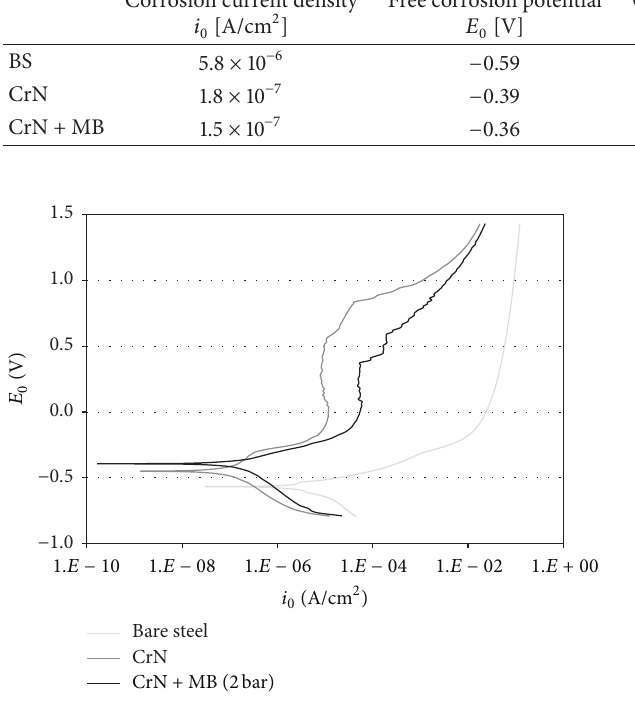
Figure 3: Potentiodynamic curves of the studied samples.